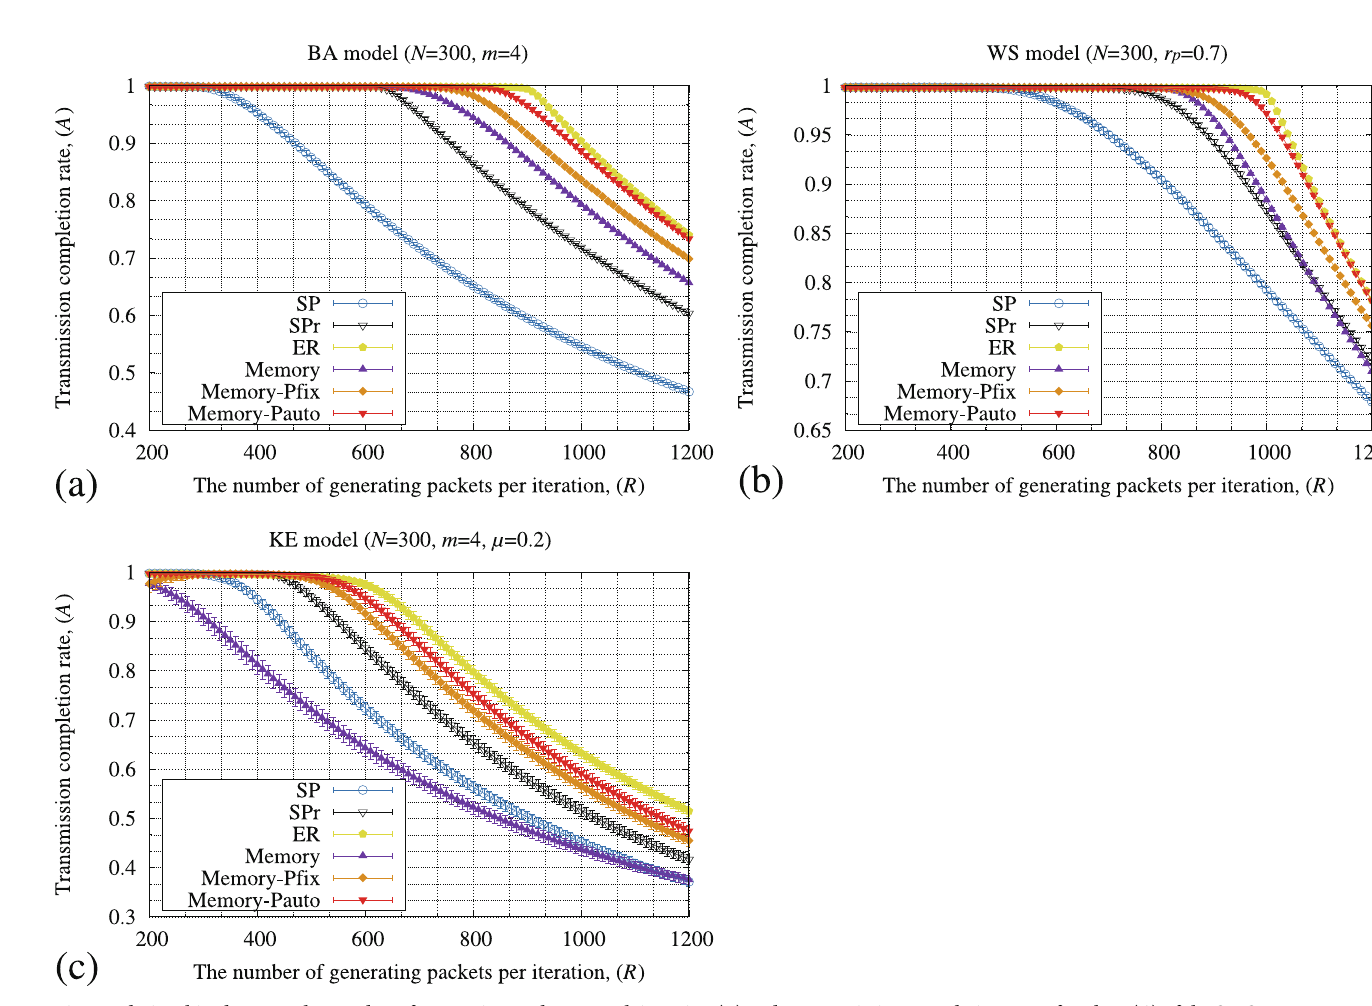
Fig 9. Relationships between the number of generating packets at each iteration ( R ) and a transmission completion rate of packets ( A ) of the SP, SPr, ER, memory, memory-pfix, and memory-pauto for the (a) BA, (b) WS, and (c) KE models. In these figures, the standard deviation of each method is plotted as error bars.